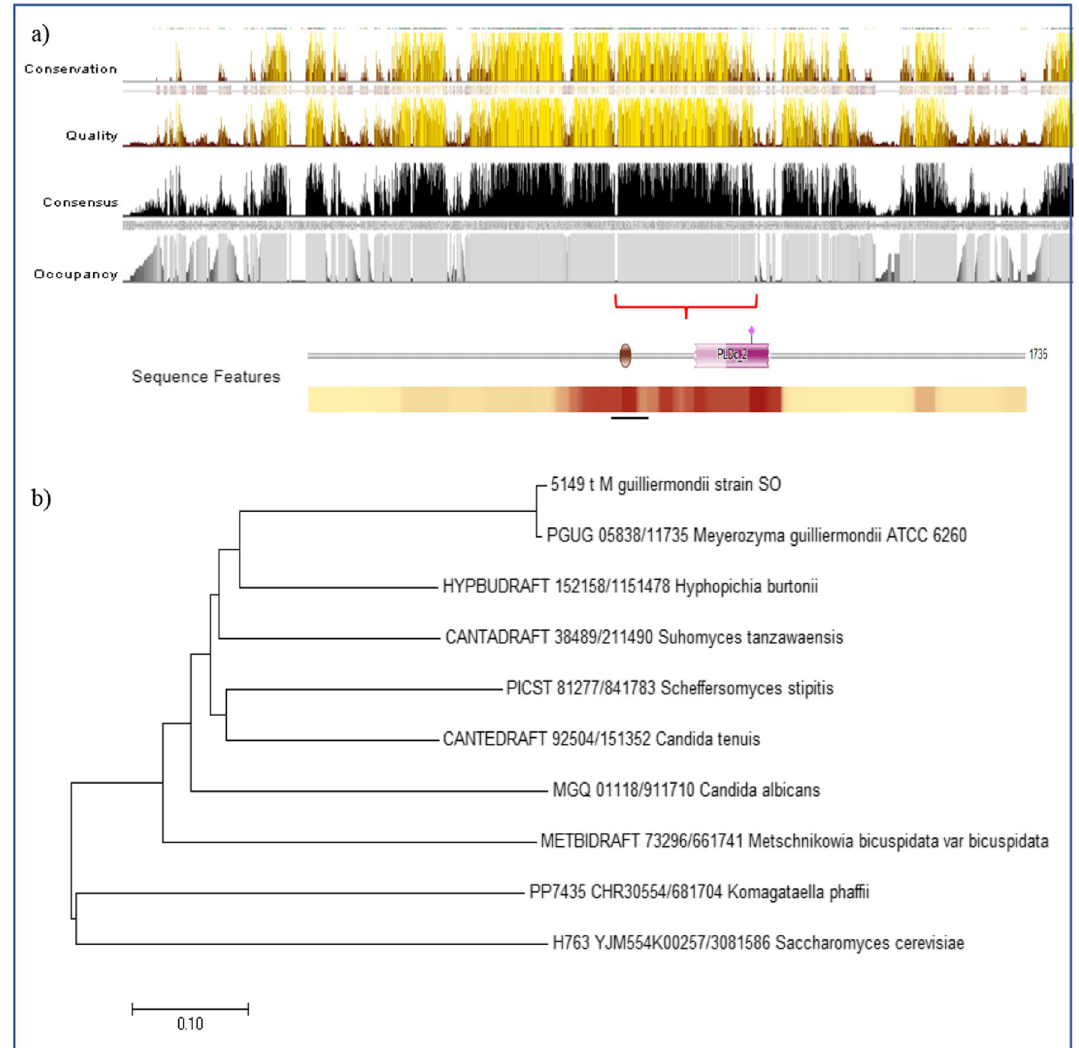
Fig. 4 Profiling of putative phospholipase D encoding gene according to public databases to signify virulence factors as indicated pathogenic in C. albicans . a The consensus region of phospholipase D from HMM hits coordinate represented using BioEdit and b the phylogenetic tree of M. guilliermondii strain SO from HMM phospholipase D